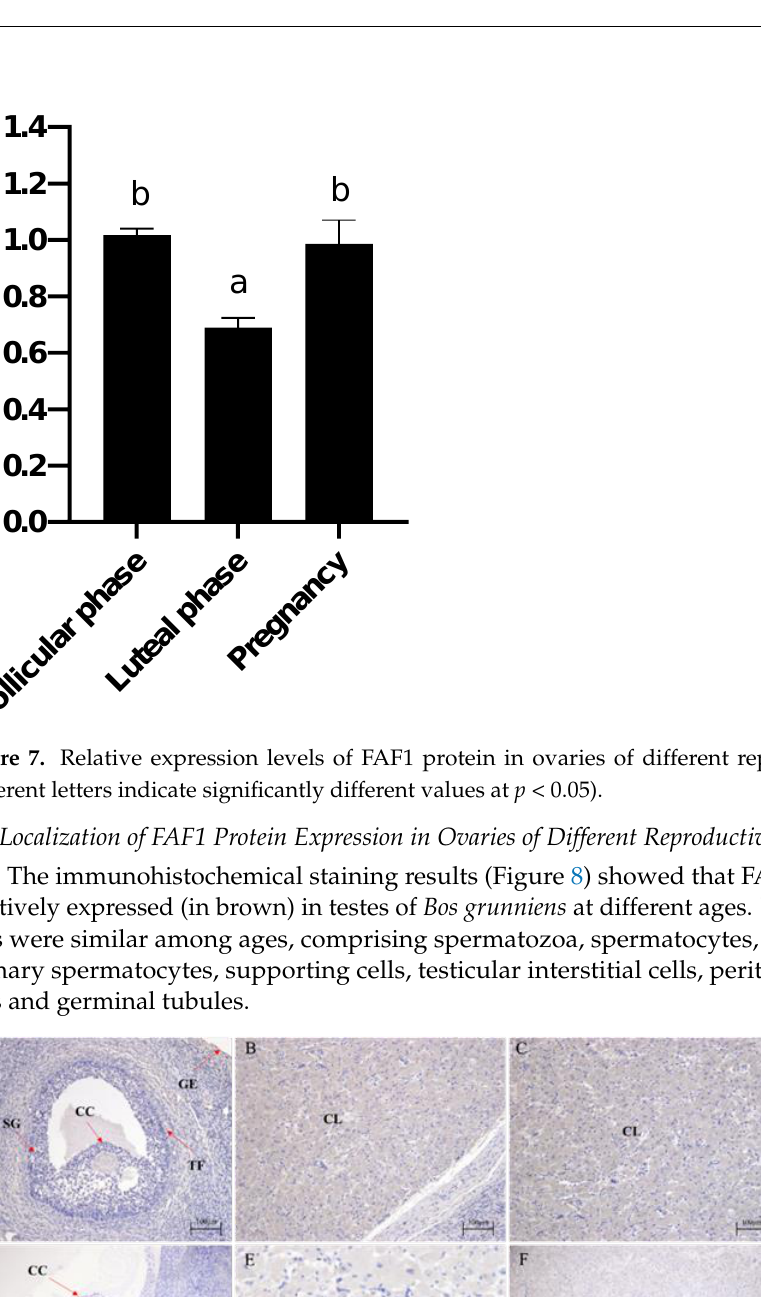
Figure 6. β -actin and FAF1 proteins detected in ovaries of different reproductive cycle phases. 1: Follicular ovary; 2: luteal phase ovary; 3: ovaries during pregnancy.